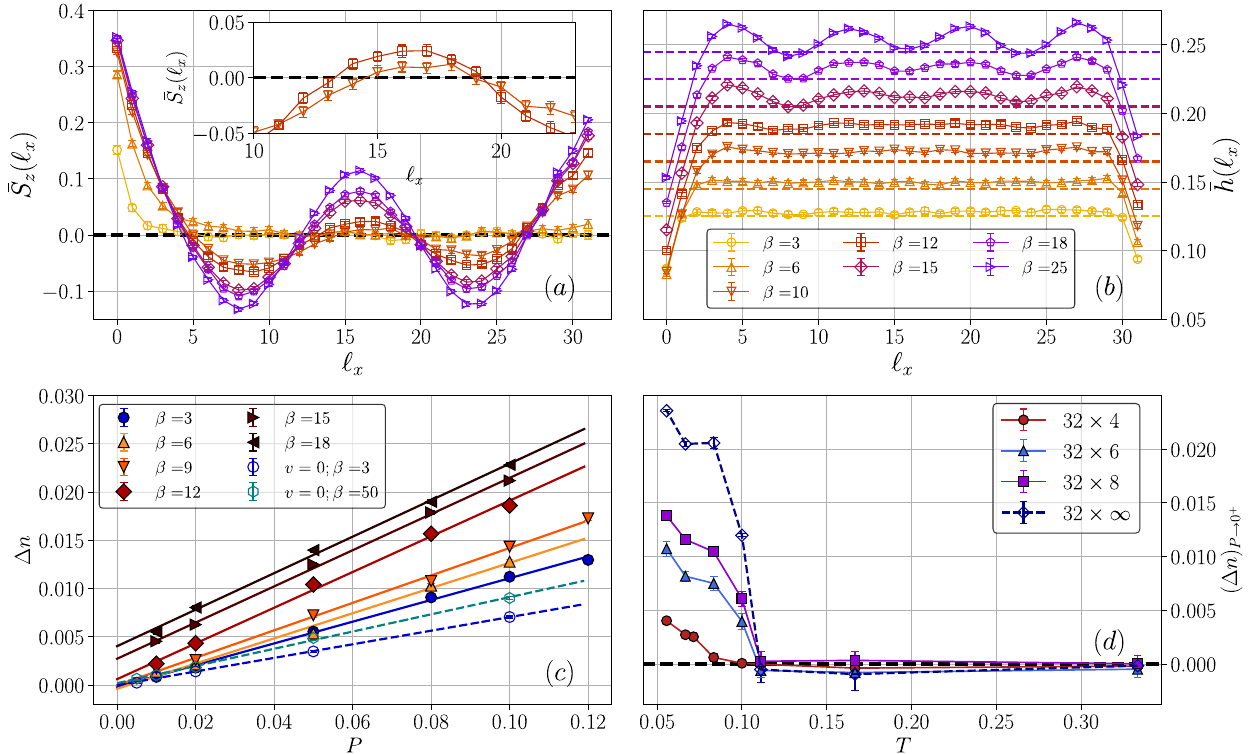
FIG. 5. The nature of spin and charge orders with δ ¼ 1 = 8 and U ¼ 8 . The top two panels have similar layout as in Fig. 4. The inset in (a) shows an enlargement of the middle region with β ¼ 10 (triangle) and β ¼ 12 (square), when the first nodes of spin modulation develop. (c) shows calculations to probe the response of the system to an applied external periodic charge potential with amplitude P . Solid lines are obtained in the presence of an additional finite edge pinning field for spin. In contrast, dashed lines show otherwise identical calculations, but without the spin pinning field. (d) shows the development of charge order as T is lowered, based on the extrapolation procedure shown by the solid lines in (c). Results in (a) – (c) are for a 32 × 4 supercell, while (d) shows three different sizes, 32 × 4 , 32 × 6 , and 32 × 8 as labeled, as well as an extrapolation to infinite transverse